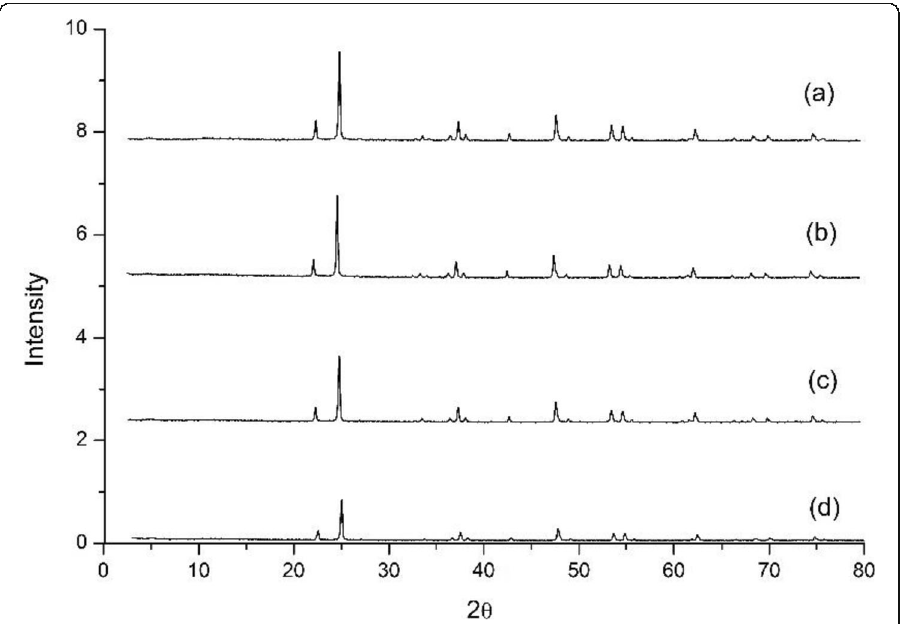
Fig. 2 XRD patterns of a TiO 2 , b TiO 2 -N,S(1:1:0.5), c TiO 2 -N,S(1:1:1), and d TiO 2 -N,S(1:1:1.5)